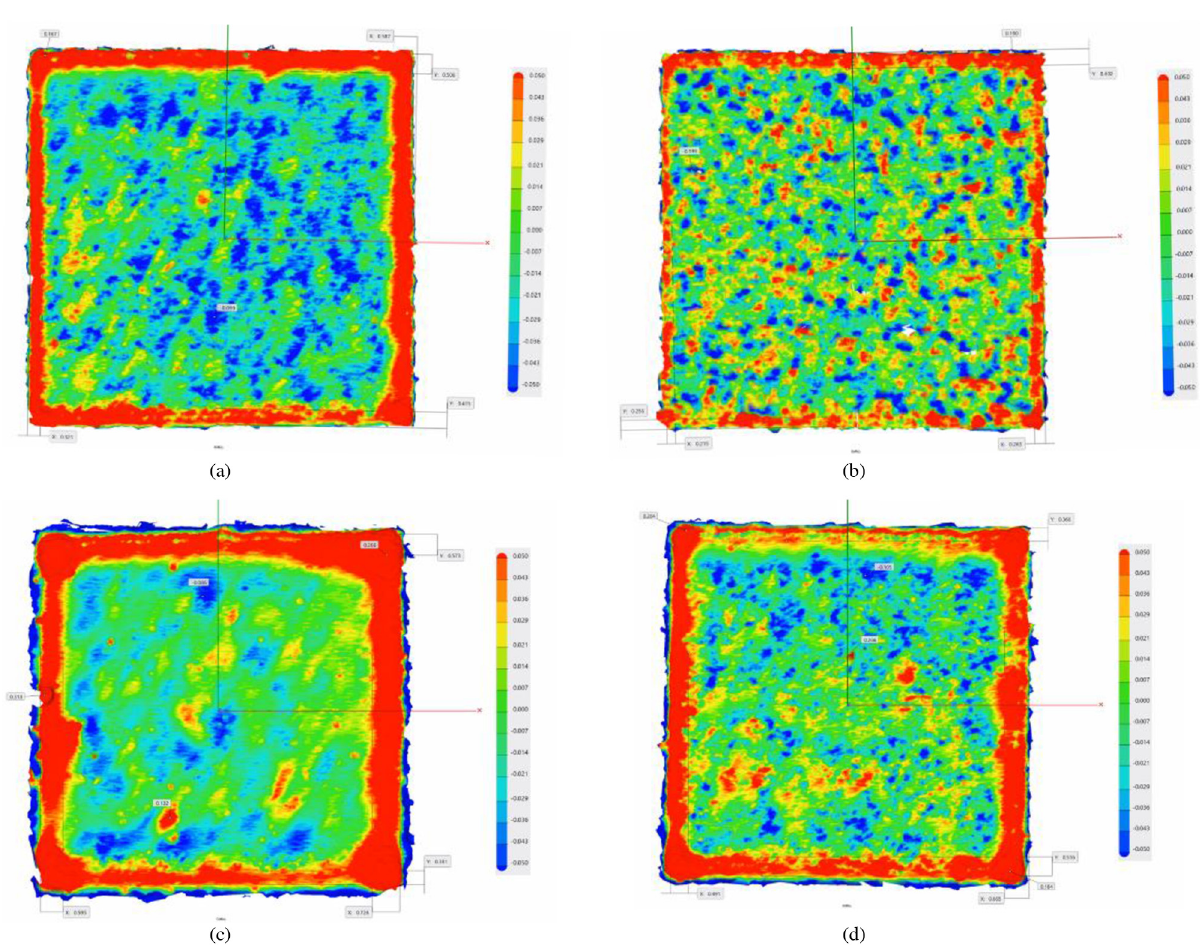
Fig. 3. Surface topography of the specimens built with constant 150 W laser power and 0.5 m · s-1 (a) and 0.9 m · s (cid:3) 1 (b), and with 350 W laser power and 0.5 m · s-1 (c) and 0.9 m · s (cid:3) 1 (d) scanning speeds.